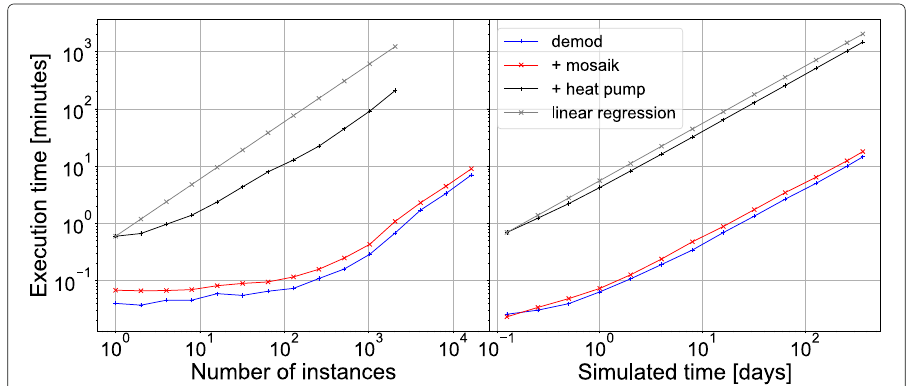
Fig. 4 Measurement of execution time of a simulation of one day with increasing number of households (left side) and 32 households with increasing simulated time (right side)